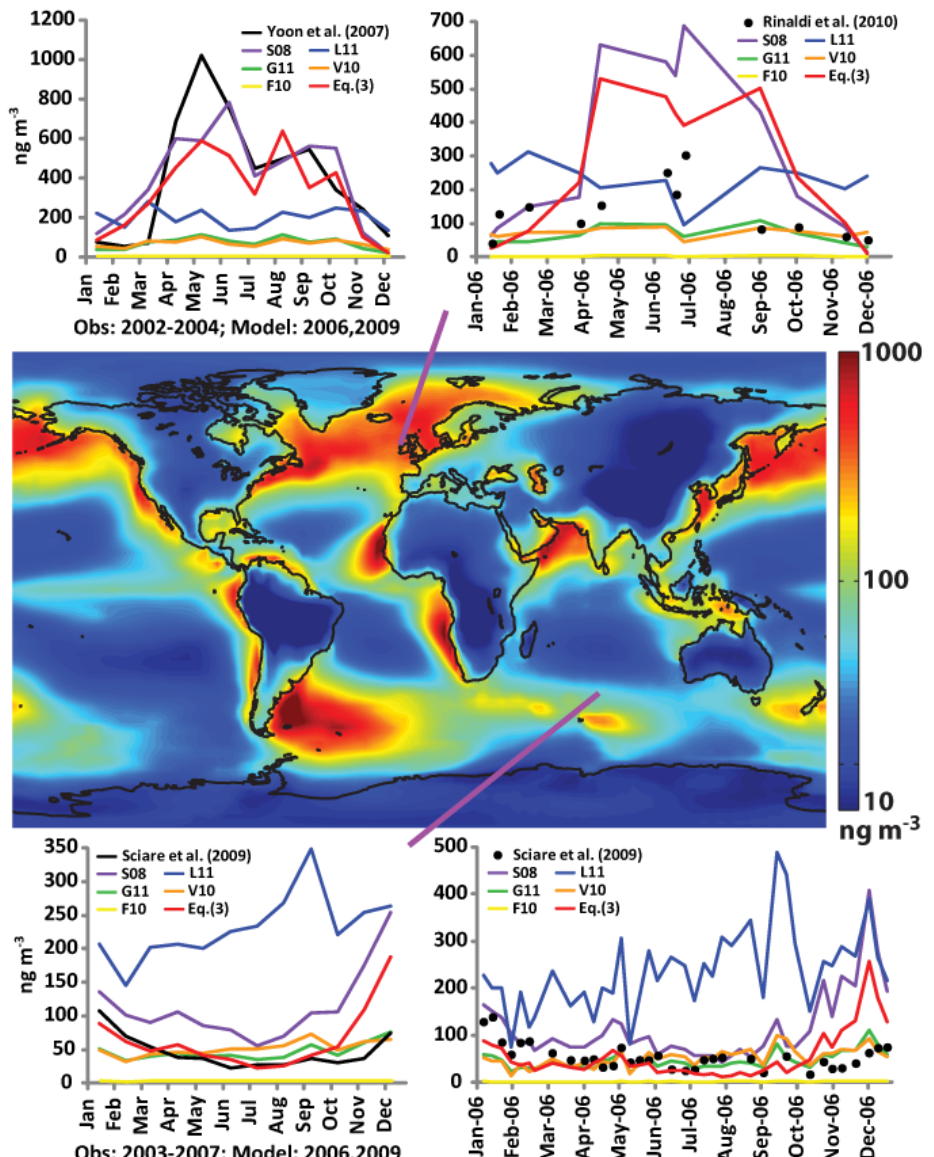
Fig. 3. Multi-year average submicron surface concentration of marine POA using the Eq. (3) emissions with the top and bottom charts comparing the multi-year monthly average (left column) and 2006 weekly average (right column) observations of WIOM concentrations with the modeled POA at Mace Head, Ireland and Amsterdam Island,